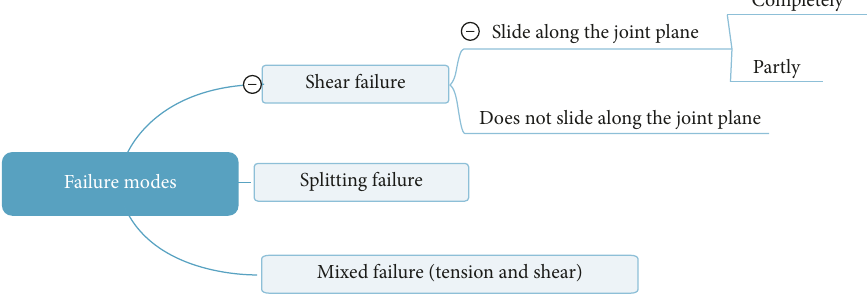
Figure 6: Failure